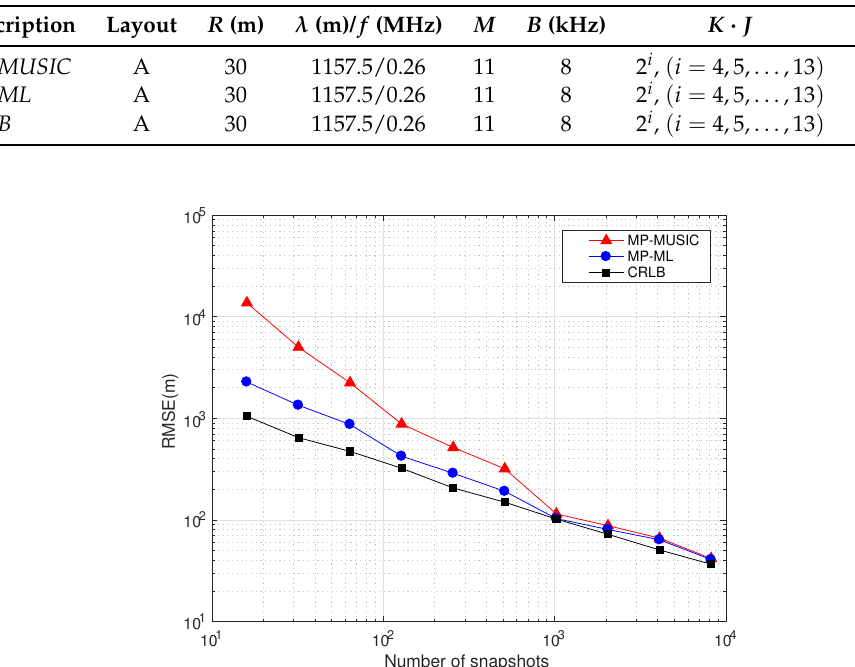
Table 5. Parameter setting in simulations of different numbers of snapshots.